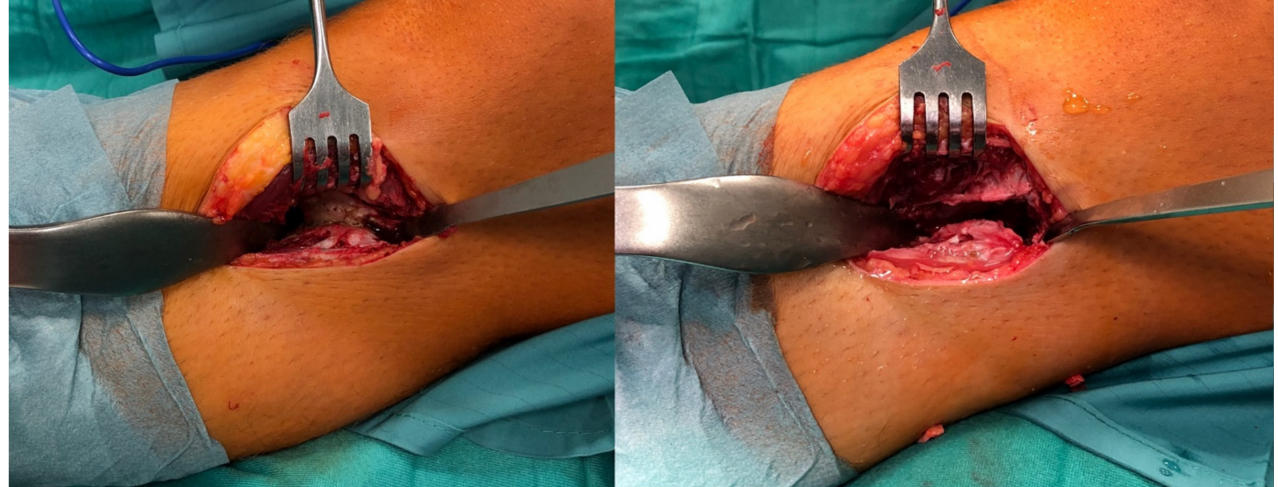
Figure 4. Intraoperative situs before ( left ) and after resection ( right ) of the synostosis of the left side; top = anterior, bottom = posterior, right = proximal, left = distal.